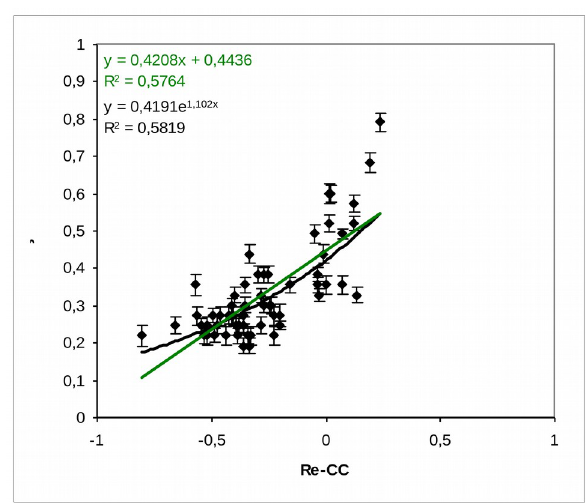
Figure 6. Correlation (linear black line, exponential green line) between ks [cm] and Re[RRLL] (Values ks<0.27 cm (~ s = 1cm) are masked